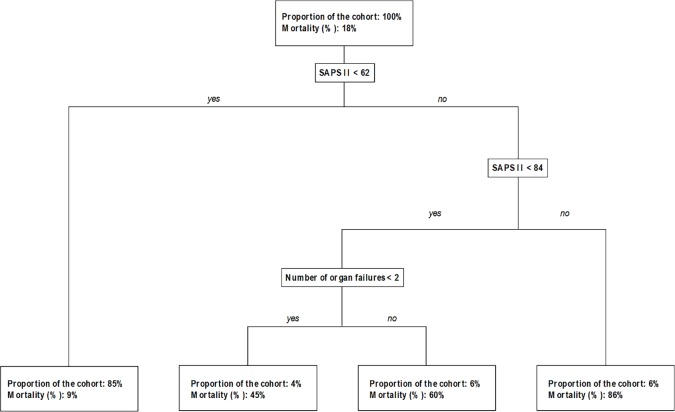
Single Classification Trees.Each node in the tree represents the splitting variable, as well as the splitting threshold for continuous variables.